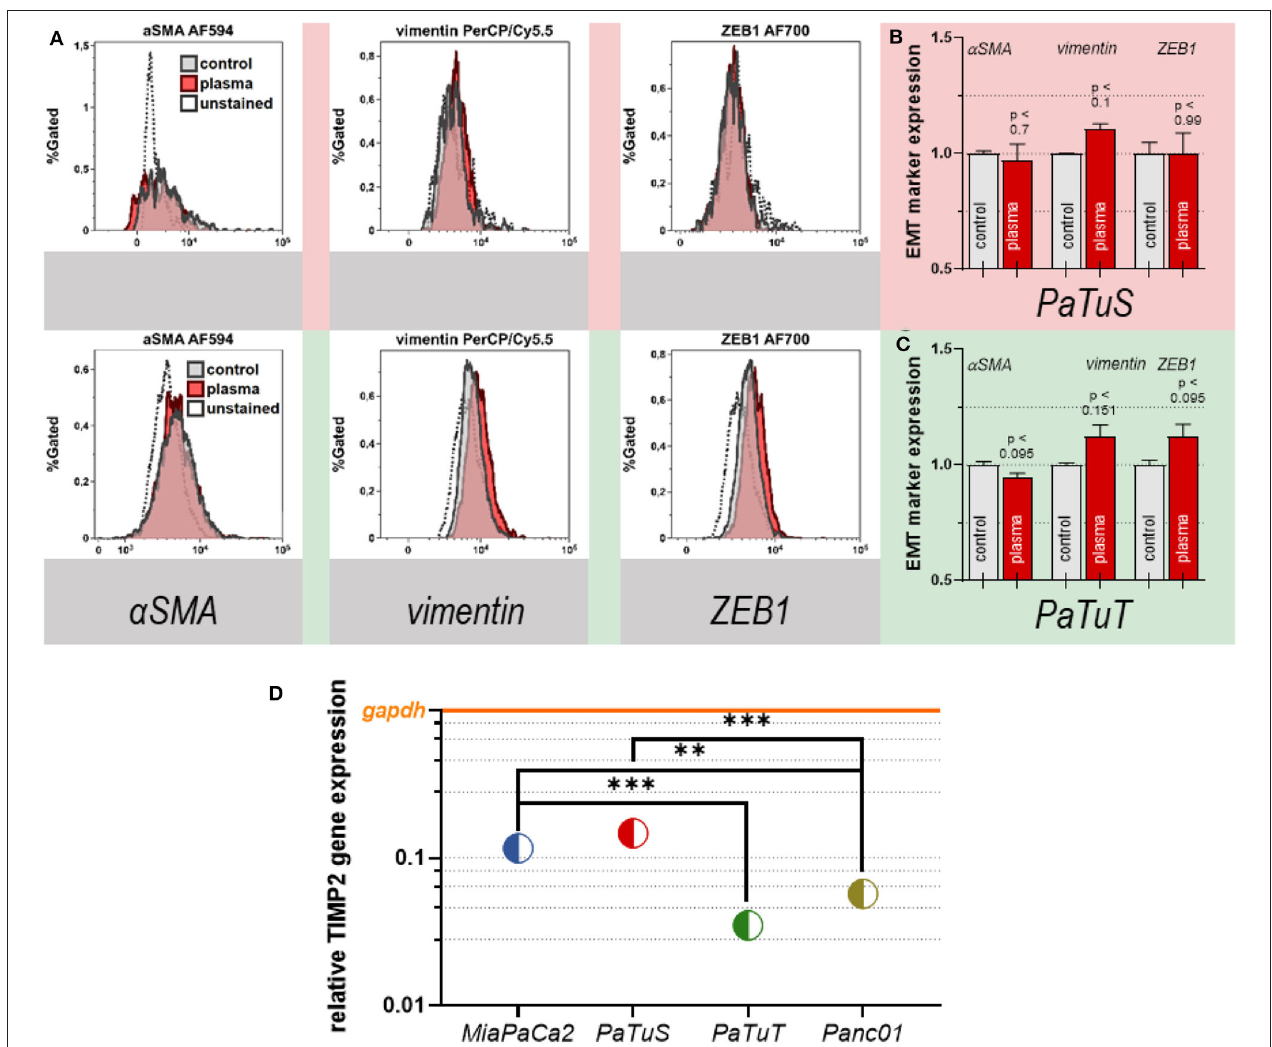
FIGURE 5 | Plasma treatment did not significantly modulate the EMT marker expression profile in vitro . (A) Overlay of the expression of the EMT marker α SMA, vimentin, and ZEB1 in PaTuS (upper row) and PaTuT cells (lower row) 24h after their exposure to 60s of plasma treatment in vitro ; (B) quantification of the expression of EMT markers in PaTuS cells; (C) quantification of the expression of EMT markers in PaTuT cells; (D) relative expression of TIMP2 in MiaPaCa2, PaTuS, PaTuT, and Panc01 cells in relation to the housekeeping gene GAPDH . Shown is (B,C) the mean + SEM, and (D) the mean only. The data (A–C) are from two independent experiments with 2–3 replicates each. ** p < 0.01 and *** p < 0.001,